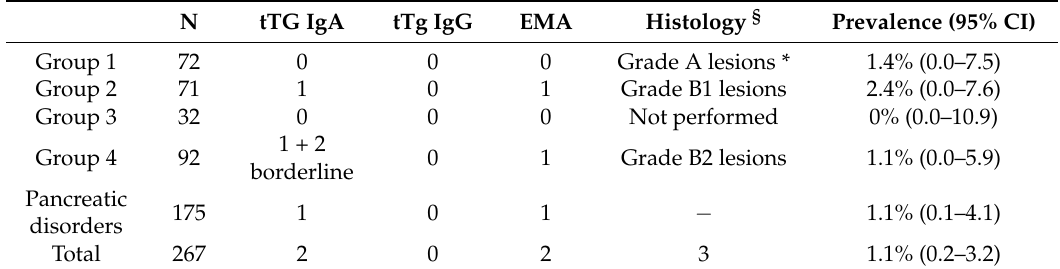
Figure 3. Abdominal magnetic resonance scan showing a diffuse enlargement of the body of the pancreas, with a “sausage ‐ like” aspect ( A ), and multiple long stenosis of the main pancreatic duct at the cholangiopancreatography sequences ( B ). Table 2. Cases with positive results at the serological screening with their histological findings. N tTG IgA